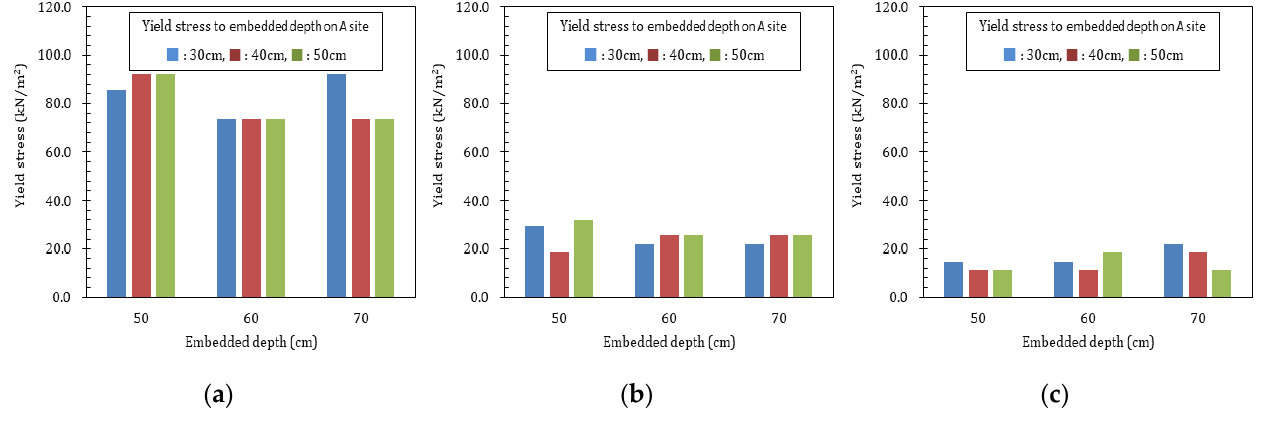
Figure 14. Yield stress to embedded depth on site A, site B, and site C: ( a ) yield stress to embedded depth on site A; ( b ) yield stress to embedded depth on site B; ( c ) yield stress to embedded depth on site C.